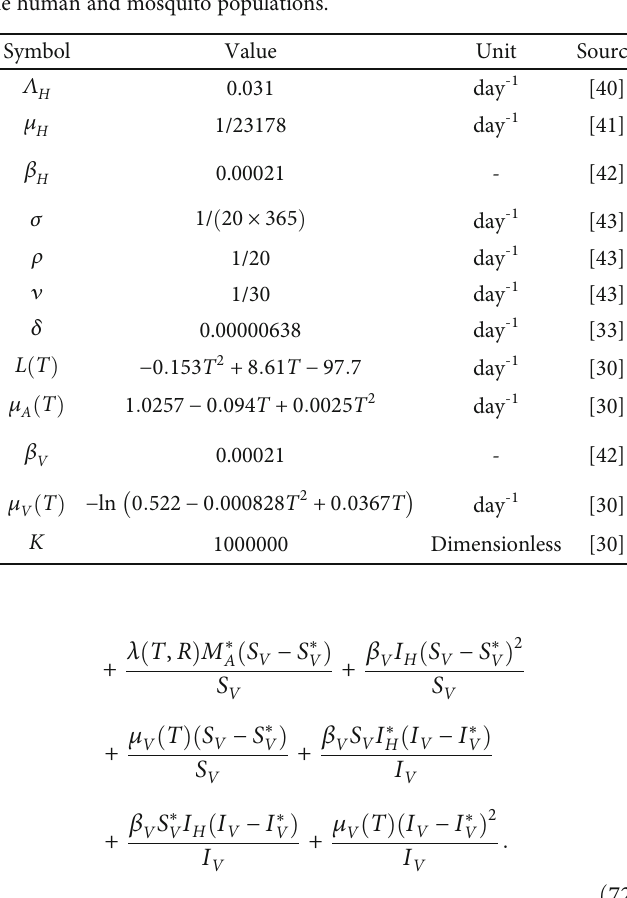
Table 2: Parameter values for the human and mosquito